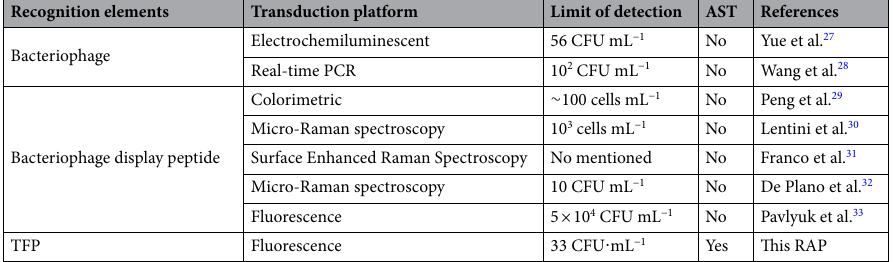
Table 3. List of several phage-based biosensors for P. aeruginosa